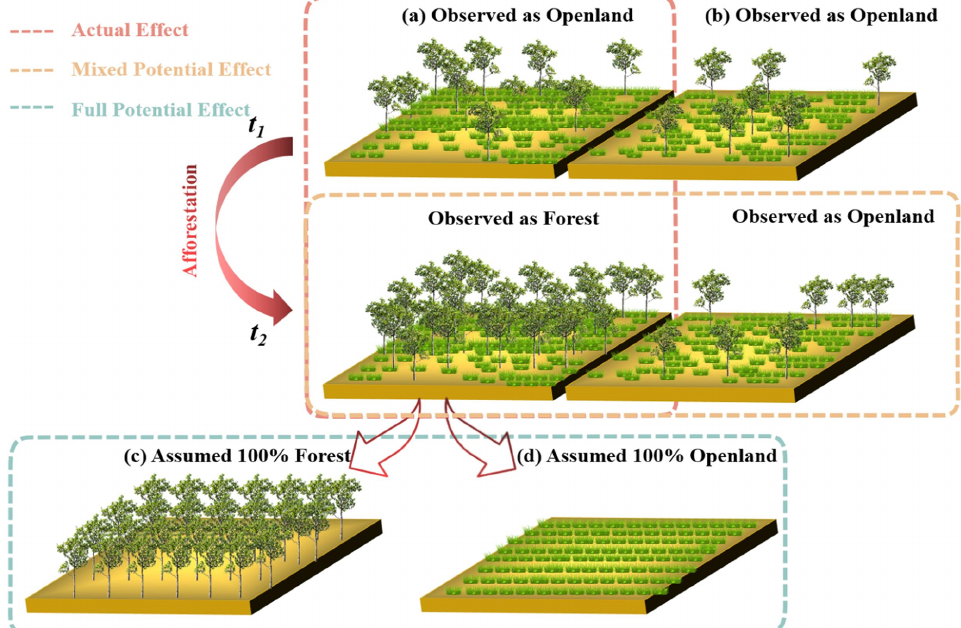
Figure 1. Illustration of the three approaches to quantifying the local surface temperature effect of afforestation. Panels (a) and (b) represent two nearby pixels, both classified as openland at time t 1 by medium-resolution satellites (1km spatial resolution), with one of them classified as forest at time t 2 (i.e., having experienced afforestation) and the other unchanged. Note that neither of these pixels will have 100% complete coverage of either openland (i.e., grassland or cropland) or forest, but they will have been classified as either openland or forest by medium- resolution satellite products. Panels (c) and (d) represent pixels with 100% forest or 100% openland coverage whose temperature can be derived from pixels of mixed land-cover types by using the singular value decomposition (SVD) technique (Duveiller et al., 2018). The dotted red box describes the quantification of the actual effect of afforestation ( (cid:49)T a ) occurring from t 1 to t 2 by the space-and-time method. The orange box represents the mixed potential effect determined by hypothesizing potential shifts between openland and forest based on the space-for-time approach ( (cid:49)T p ). The green box represents the full potential effect of afforestation ( (cid:49)T p ) derived by hypothesizing a 1 2 transition from 100% complete openland coverage to 100% complete forest